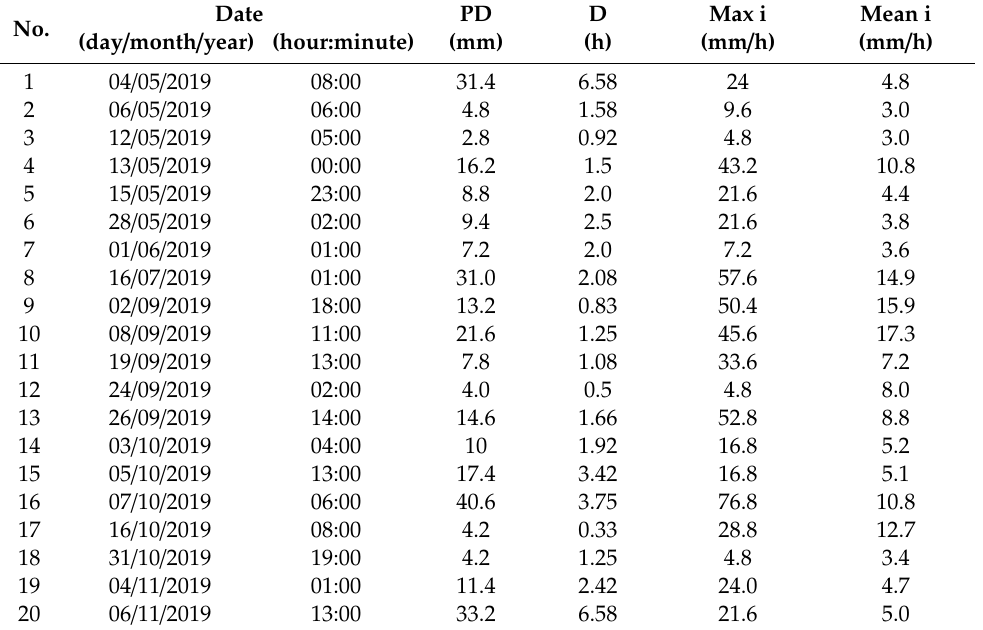
Table 1. Hydrological characteristics of each rainfall event recorded from May 2019 to May 2020. PD: precipitation depth, D: rainfall duration, Mean i: mean rainfall intensity, and Max i: maximum rainfall